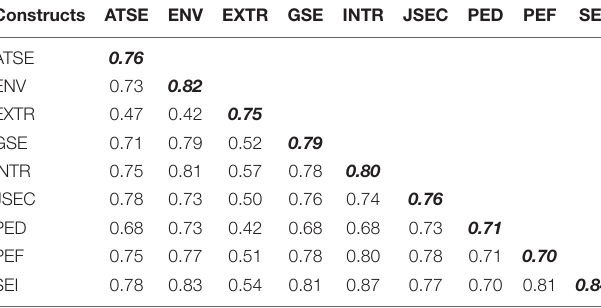
TABLE 5 | Discriminant validity of the total sample (Fronell–Larcker criterion).